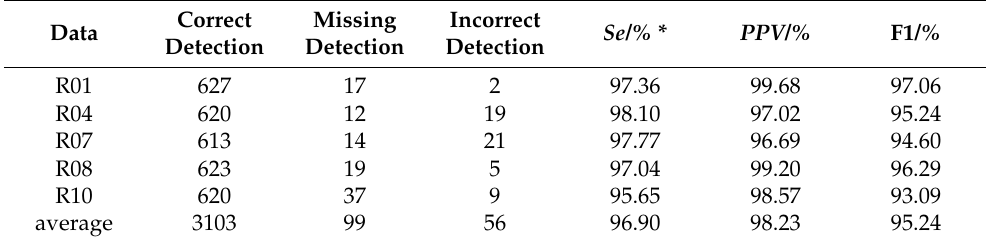
Table 3. FECG signal detection performance evaluated by five datasets from the ADFECGDB